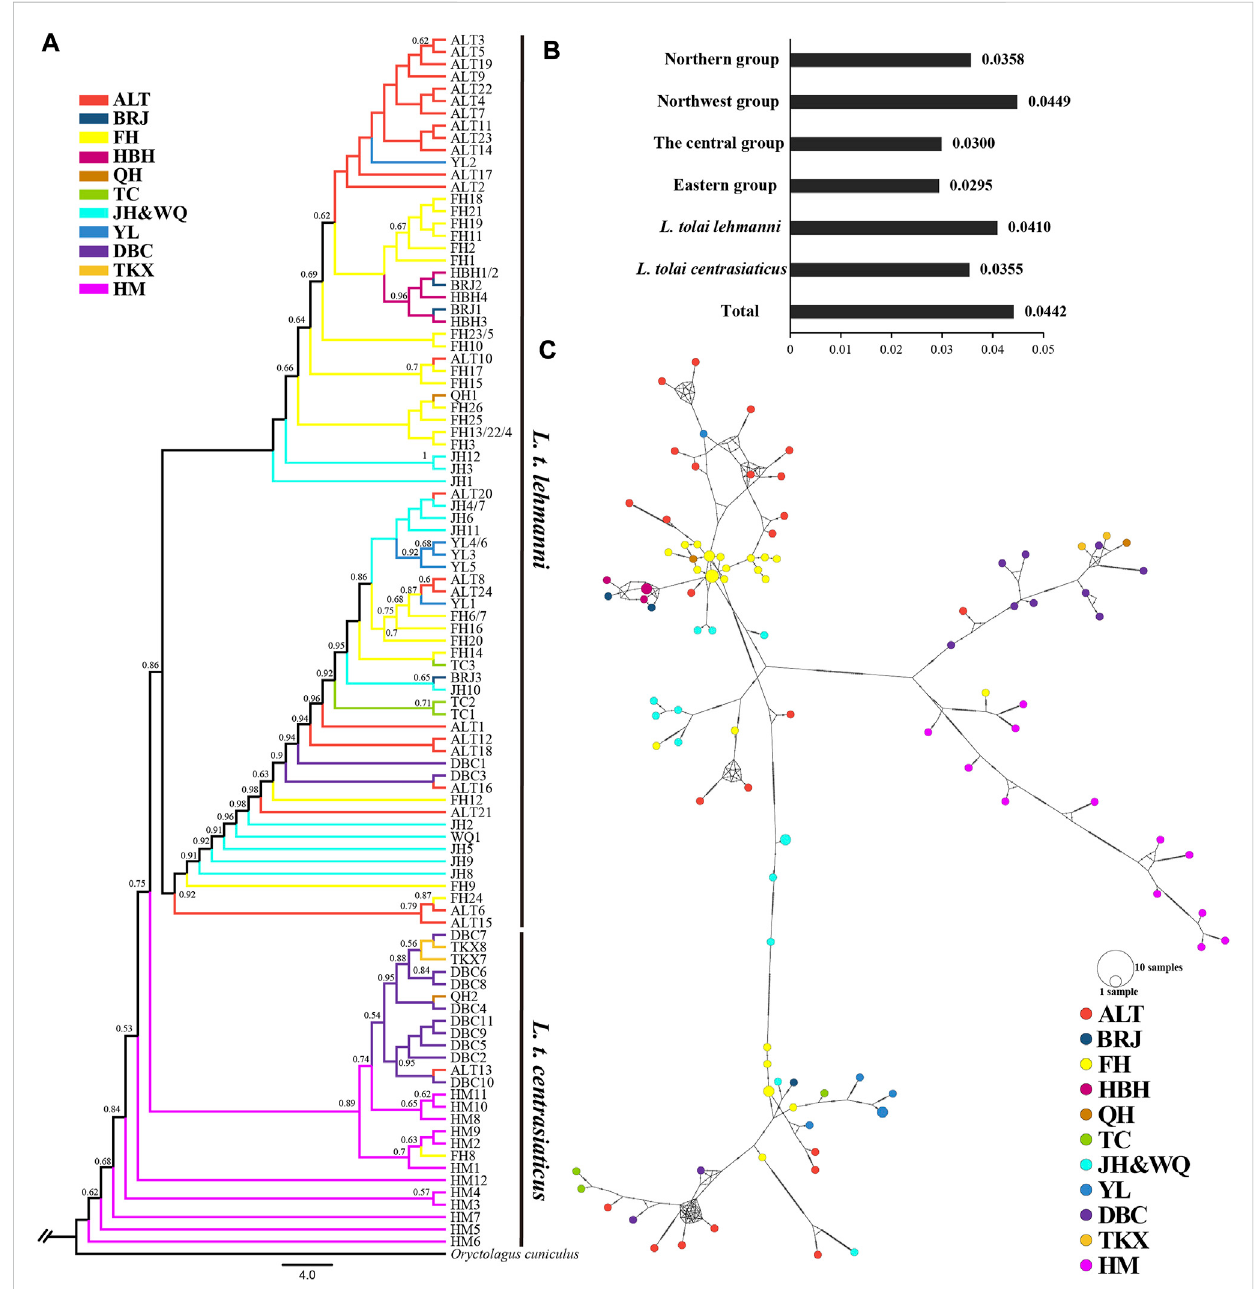
FIGURE 3 Genetic diversity and population structure of Tolai hares in Xinjiang based on mtDNA. (A) . Phylogenctic tree constructed using ML method. (B) . Nucleotide diversity ( π ). (C) . Median-joining network of Tolai hare haplotypes. The hatch marks on the line indicates the mutation